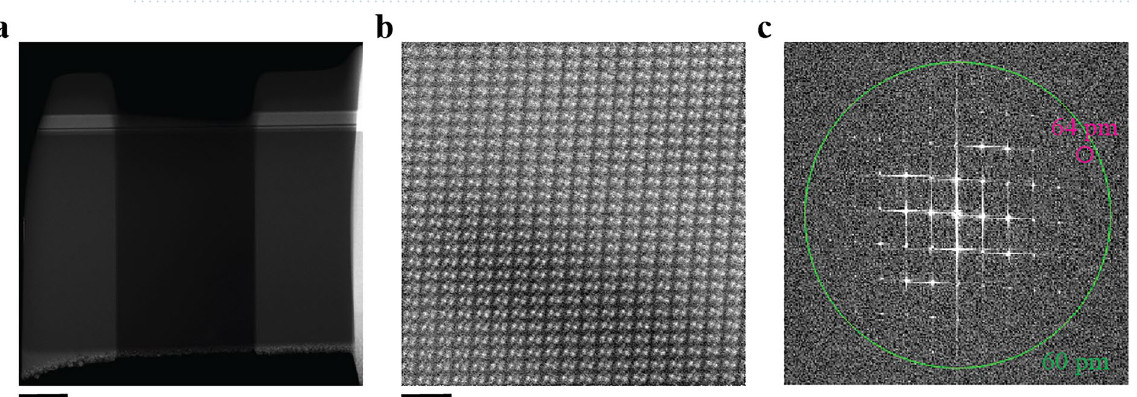
Figure 7. Aberration-corrected STEM imaging of a robotically prepared sapphire lamella. ( a ) A HAADF- STEM image of the entire sapphire lamella. ( b ) An atomic-level HAADF-STEM image near the edge of the sapphire sample. See Ref. 32 for the atomic model of this material. ( c ) FFT pattern of ( b ). Scale bars in ( a,b ) correspond to 1 μm and 1 nm,